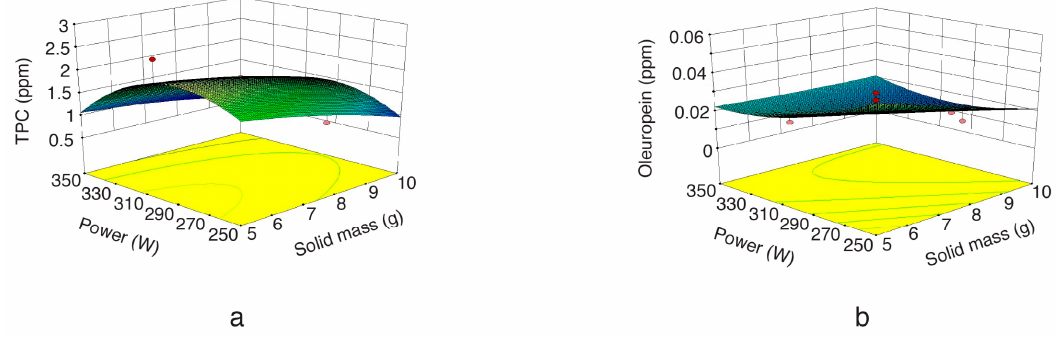
Figure 1. Response surface plot for the TPC ( a ) and oleuropein ( b ) from olive leaf extract as a function of microwave irradiation power to solid mass (extraction time = 2.5 min).